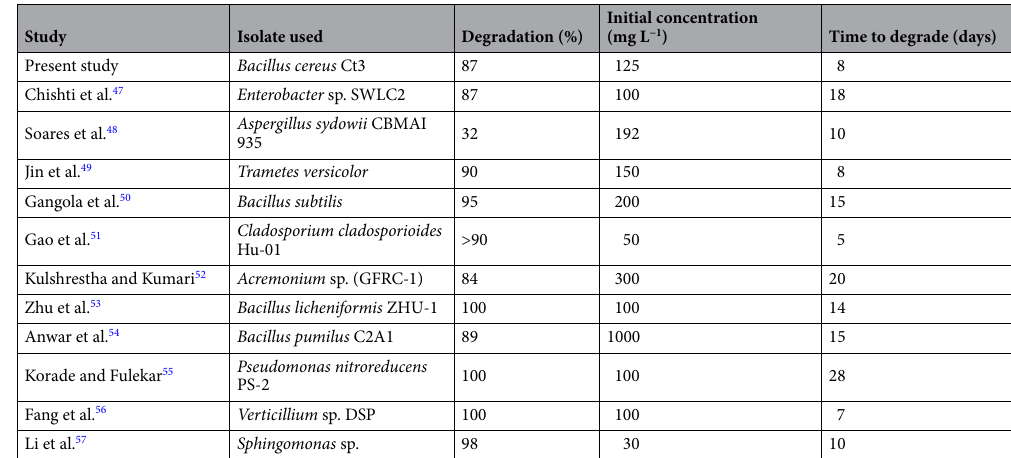
Table 3. Comparison of chlorpyrifos biodegradation efficiencies.